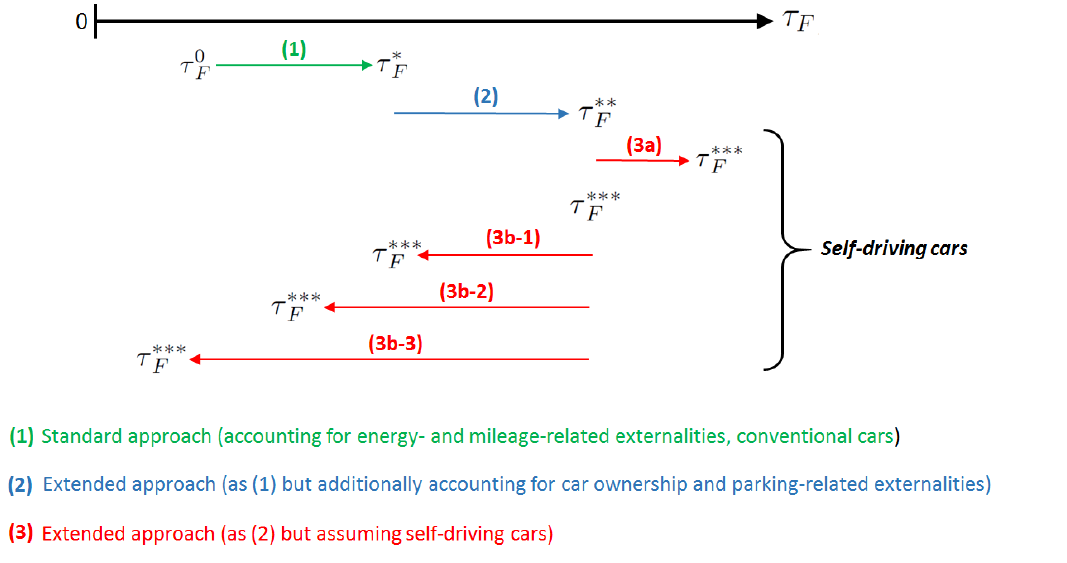
Figure 3. Stepwise change in optimal transport taxes owing to self-driving